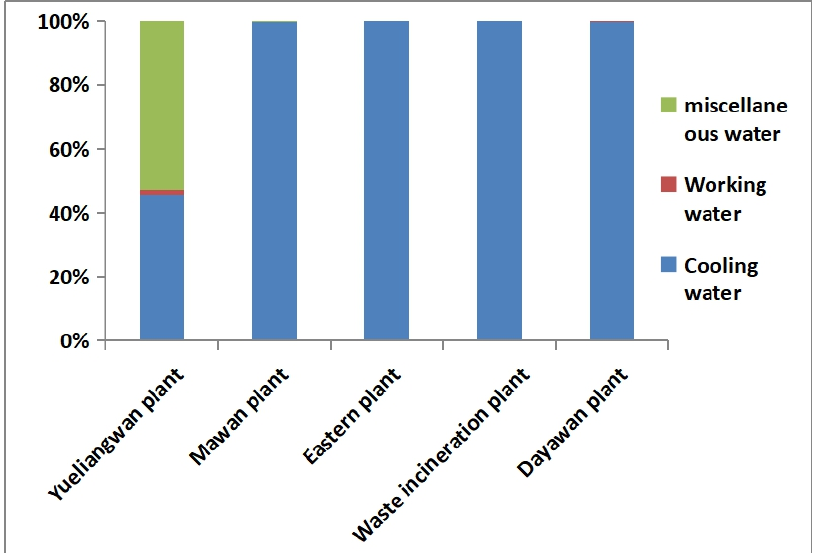
Figure 11. The proportion of water consumption for typical power plants in Shenzhen.